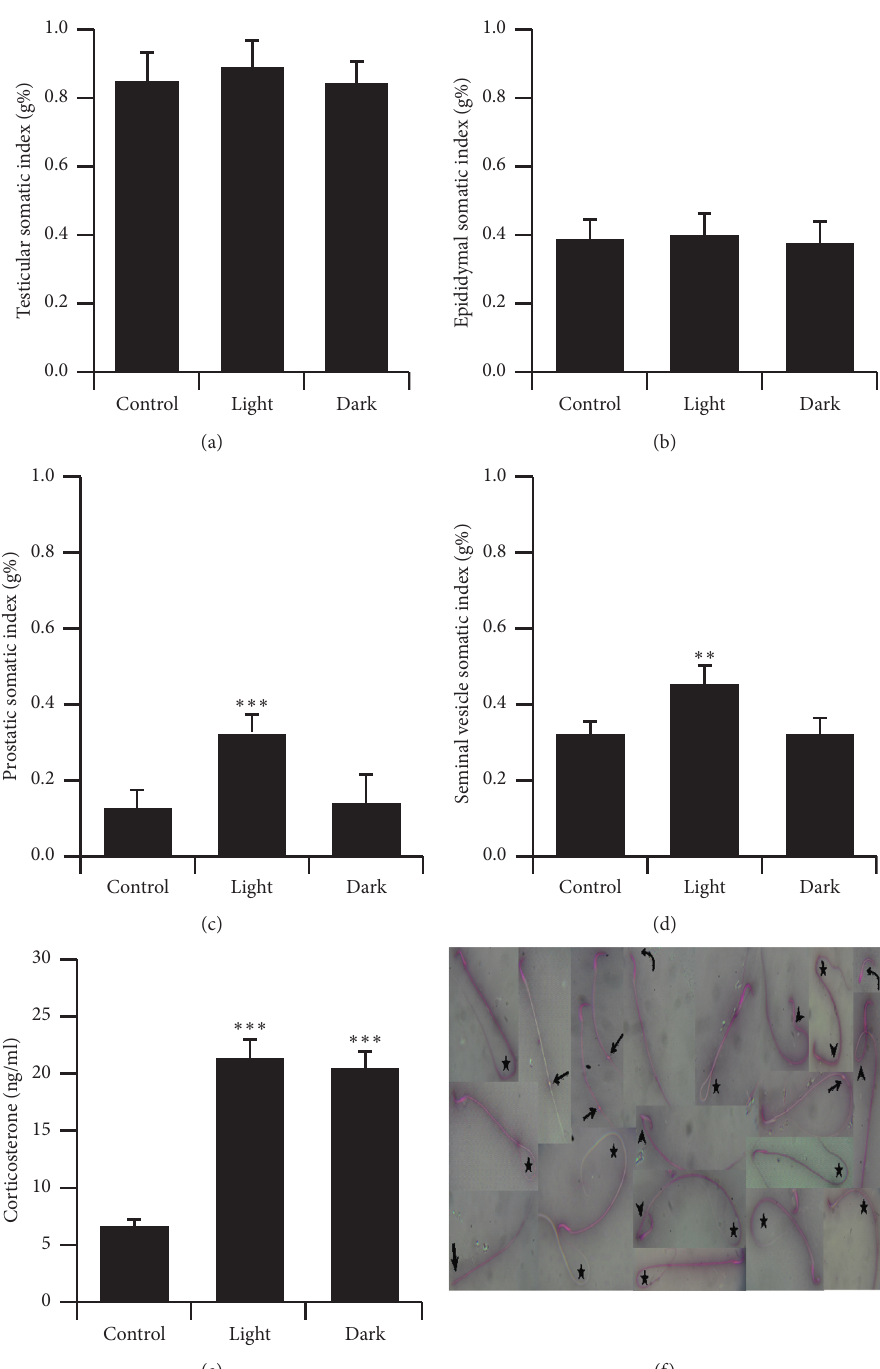
Figure 1: Relative changes in the reproductive organs weight and corticosterone levels. Somatic index of (a) testes, (b) epididymides, (c) prostates, and (d) seminal vesicles of male rats exposed to prolonged light or prolonged darkness ( n � 8–10 rats). (e) Serum corticosterone concentrations ( n � 8–10 rats per group) (ng/ml). ∗∗ P ≤ 0 . 01 and ∗∗∗ P ≤ 0 . 001 vs the control group by Student’s t -test. (f) Photomicrographs illustrating various sperm abnormalities. Asterisks, tail defects; arrows, protoplasmic droplets; arrow heads, midpiece defects; curved arrows, head defects; thick arrow, detached